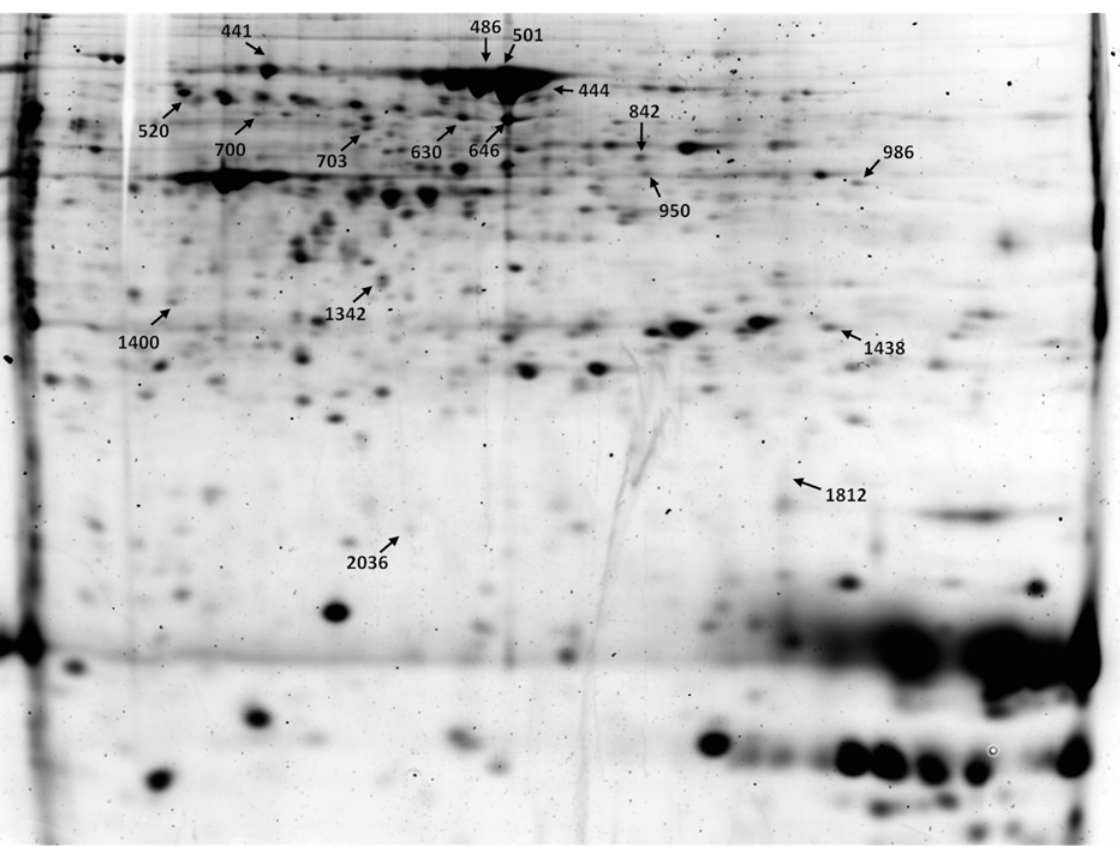
Fig 3. Representation of 2D-DIGE gel at Day 24. Proteins picked for identification are outlined with an arrow and the tagged numbers correspond to the same ones indicated in Table 3.